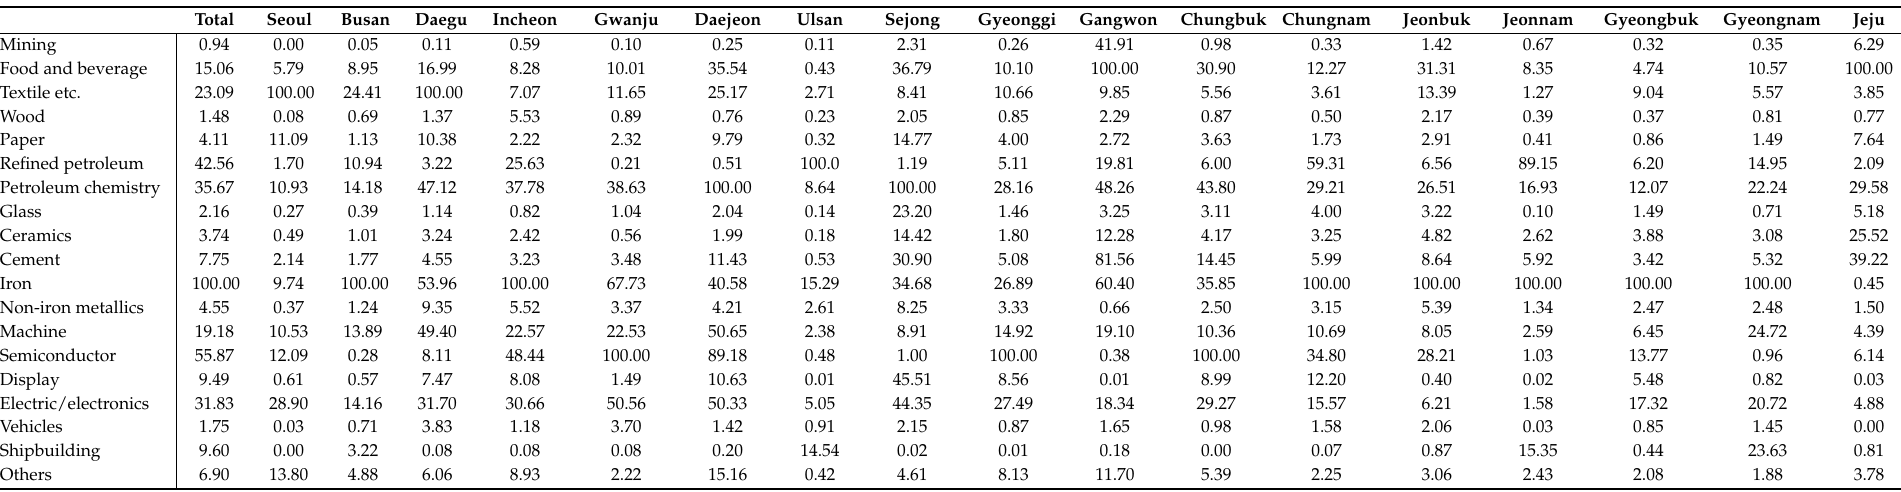
Table 5. Weight of each MM industry in 17